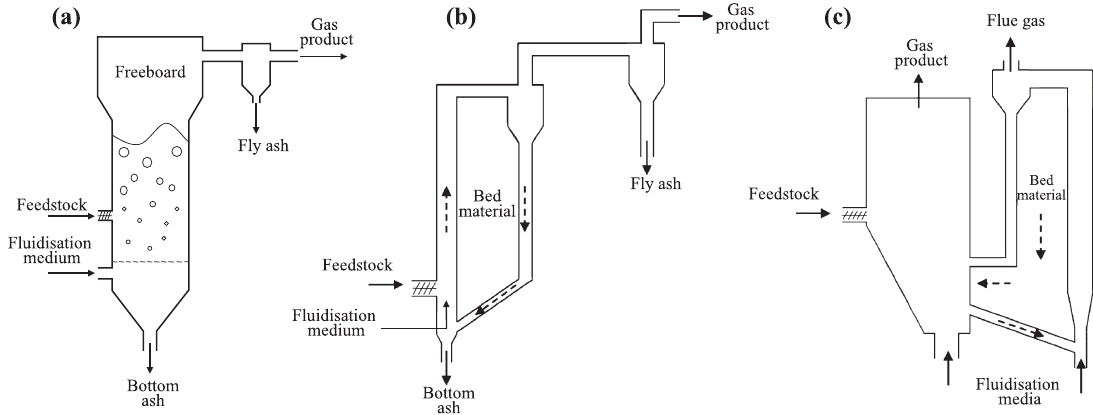
Fig. 2 Fluidised bed reactor configurations: (a) bubbling; (b) circulating; (c) dual. Source: Adapted from Motta et al.